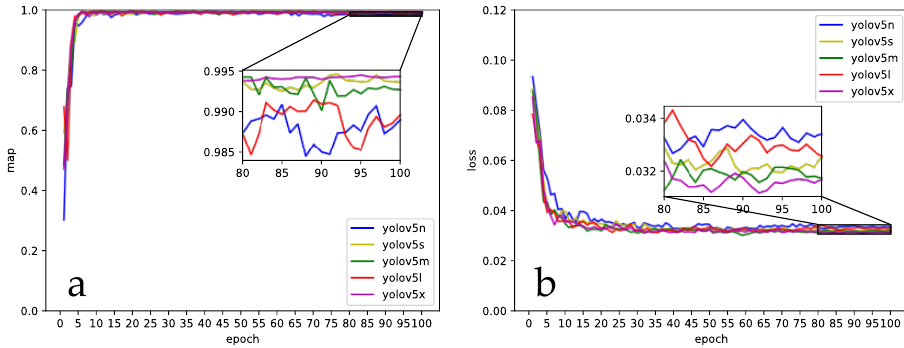
( c ) Figure 14. Some of the dataset images ( a ) Long garlic root; ( b ) Medium garlic root; ( c ) Short garlic root. Model training was performed using the server provided by AutoDL (GPU Rental Sites) with the following configuration: a RTX 3090 GPU and a 15-core AMD EPYC 7543